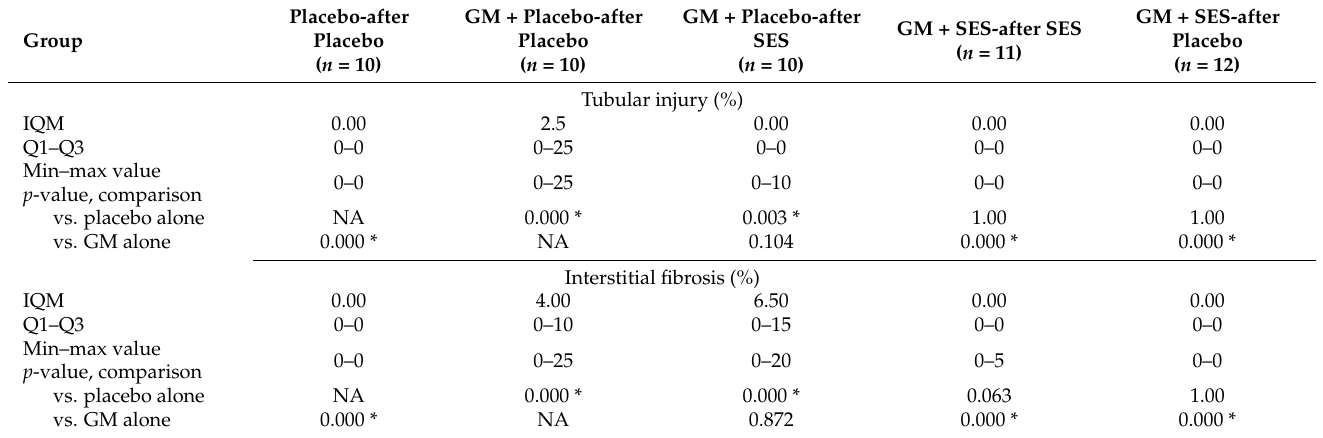
Table 1. Paired comparison of kidney histopathologic